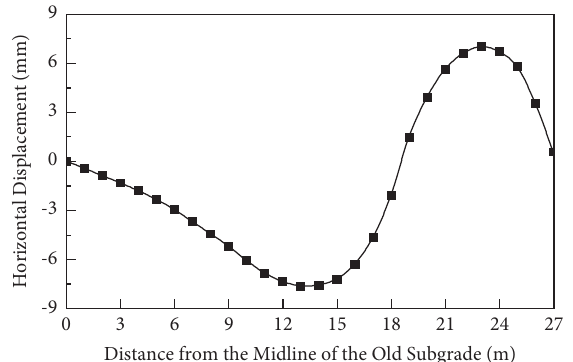
Figure 9: Horizontal displacement at the foot of old roadbed slope.